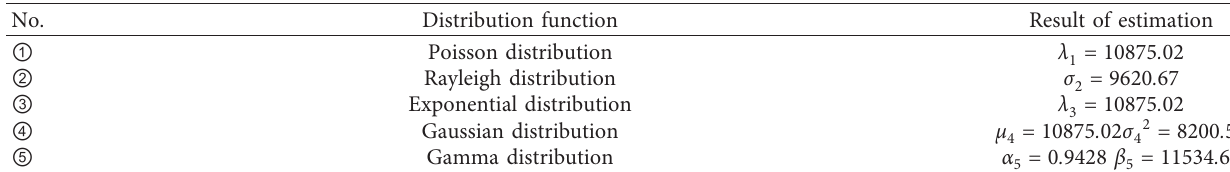
Figure 7: The variation of bike-sharing usage between different hours. Table 3: The results of parameter